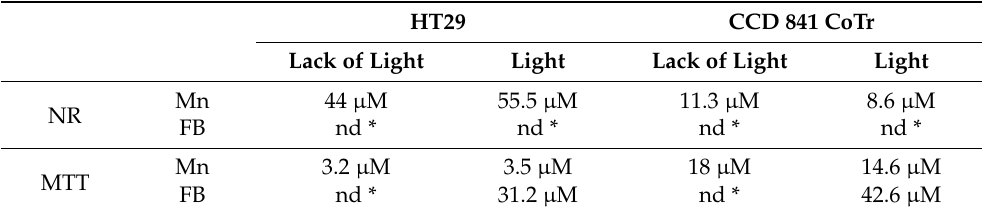
Table 1. EC50 values obtained after 24 h incubation of human colon tumor cell (HT29) and human normal colonic epithelial cell (CCD 841 CoTr) with manganese porphyrin (Mn) and free-base por- phyrin (FB) after light induction and in the absence of light (MTT and neutral red analysis). Statistical significance was analyzed at p <